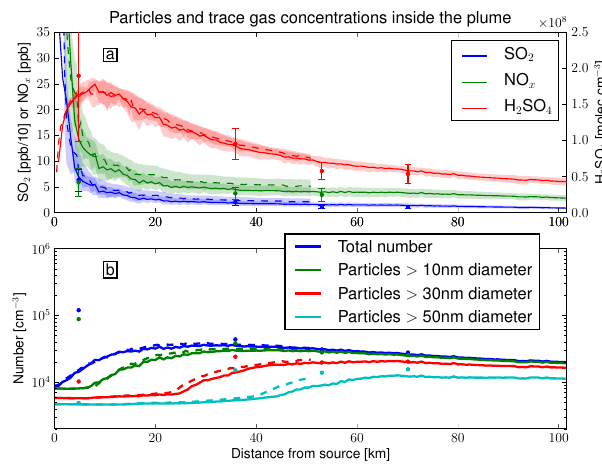
Fig. 3. (a) Trace gases and (b) particle number vs. distance down- wind from the Parish power-plant, averaged over plume. Dots are aircraft observations; lines are model results. Shaded area and error bars indicate one standard deviation in concentration across plume width. Solid lines indicate 800 × 800 × 40m model resolu- tion; dashed lines indicate 400 × 400 × 40m model